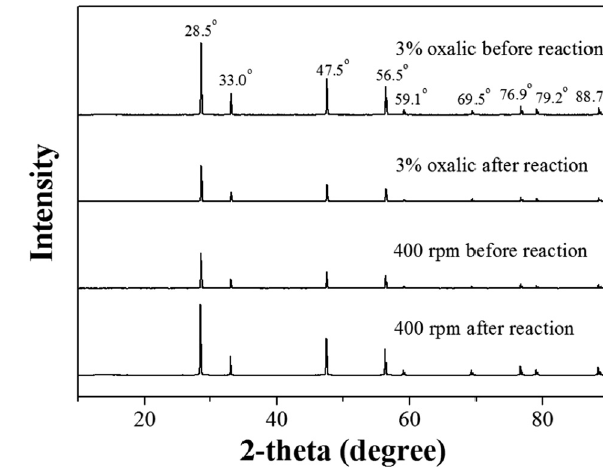
Figure 7: XRD patterns of CeO 2 before and after the reaction using 3% oxalic concentration ( at 400 rpm stirring rate ) and using 400 rpm stirring rate ( at 3% stirring rate ) .